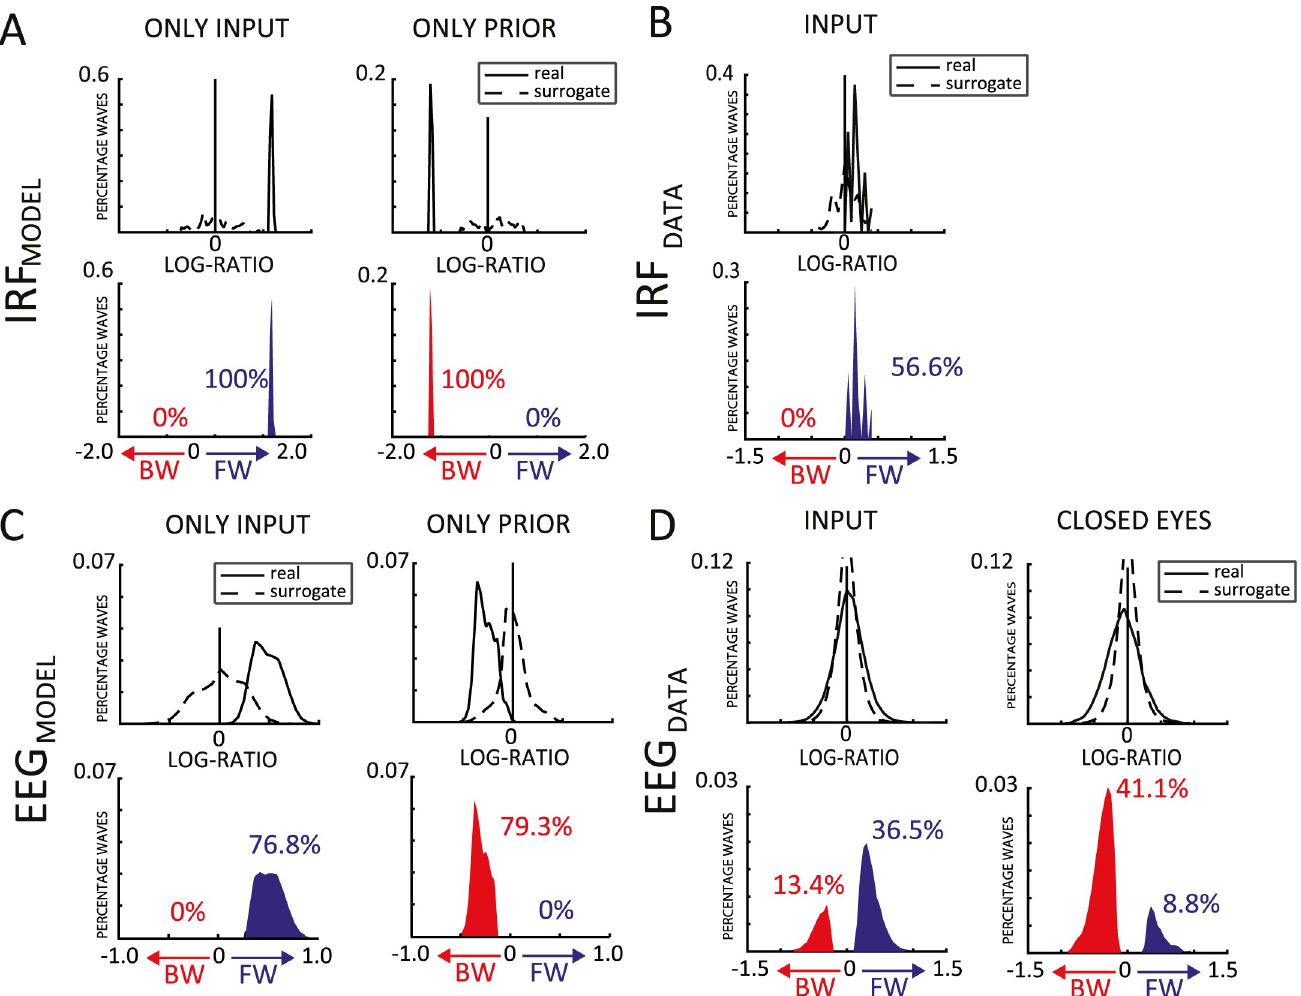
Fig 4. Quantification of traveling waves in human EEG data and in model simulations. (A) The first row shows the real (solid line) and shuffled (dashed line) distributions of log ratios computed over the IRF obtained during 2 sets of simulations, cross-correlating prediction signals (a proxy for the EEG in our model) either with the sensory inputs (first column), or with the top-down prior signals (second column). The second row shows the difference between the two, focusing on positive values, i.e., the traveling-wave events in the data that occur more often than predicted by the null distribution. The proportion of significant BW and FW waves are shown in red and blue, respectively. (B) Same as (A), but for the IRF computed in the INPUT human EEG dataset (during human EEG experiments, we only have direct access to the visual input signals, but the top-down priors, if any, remain unknown and cannot be used for cross-correlation). (C,D) Same as (A,B), but based on log ratio values computed directly in 1s EEG epochs, rather than in the IRF (for the model, we use the prediction signals y i as a proxy for the EEG signals). Experimental human EEG results (B,D) follow the same qualitative pattern as the simulations (A,C). All data are available at: